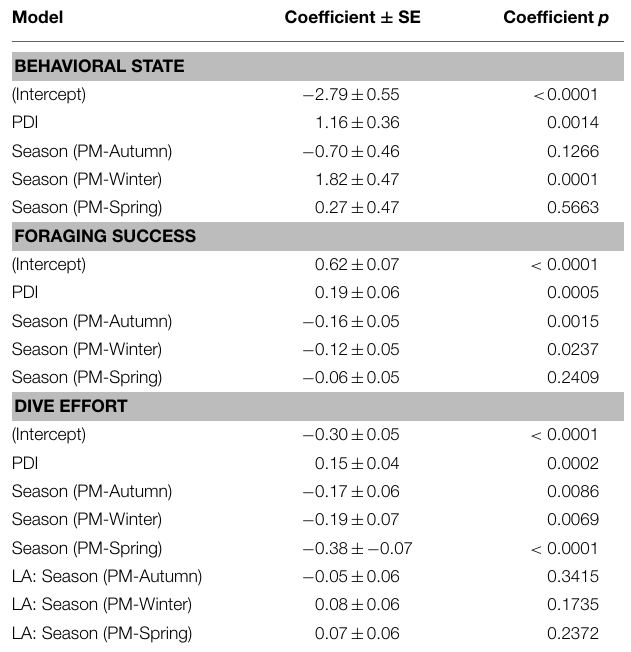
TABLE 2 | Coefficients from our most parsimonious generalized mixed-effects models relating the plankton density index (PDI) to each behavioral metric (i.e., behavioral state, foraging success, dive effort).